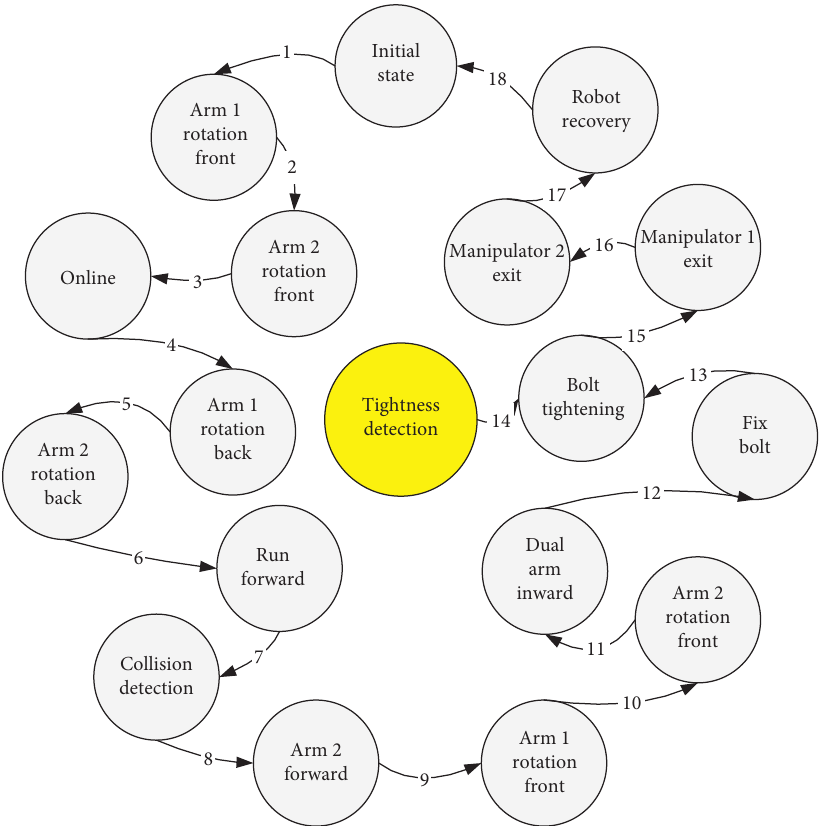
Figure 9: FSM design of drainage plate tightening